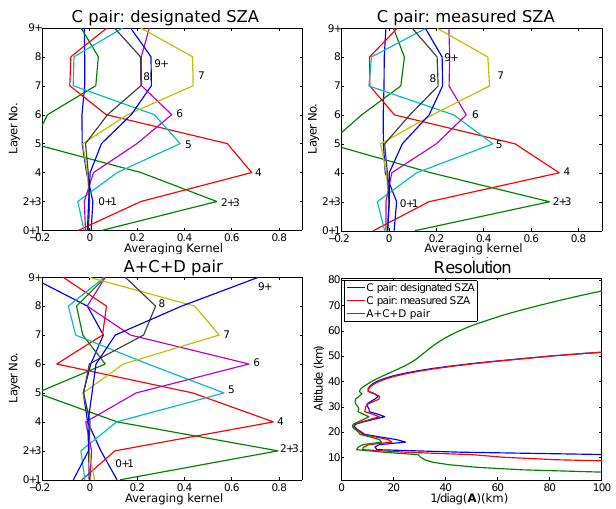
Figure 4. Averaging kernels and resolution for a retrieval at Mel- bourne for 28 January 1994 for 8 Umkehr layers defined when us- ing just the C-pair measurements and the A + C + D-pair measure- ments in the retrieval. The averaging kernel for each layer is labelled in each